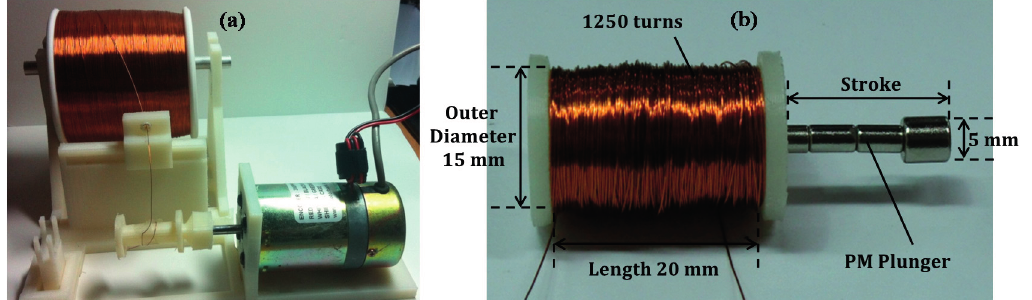
Figure 4. Design of a solenoid actuator with a PM plunger: ( a ) winding machine for